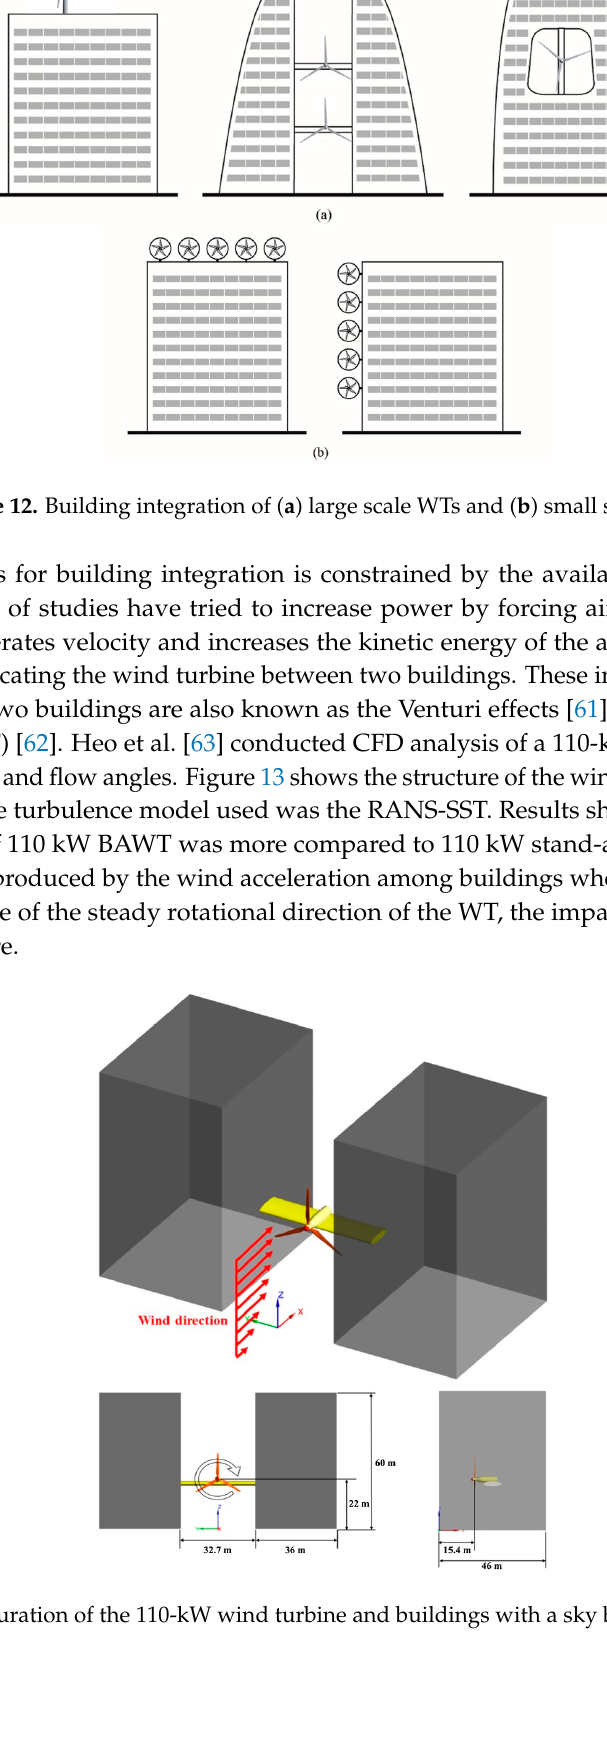
Figure 13. Configuration of the 110-kW wind turbine and buildings with a sky bridge studied in [63].